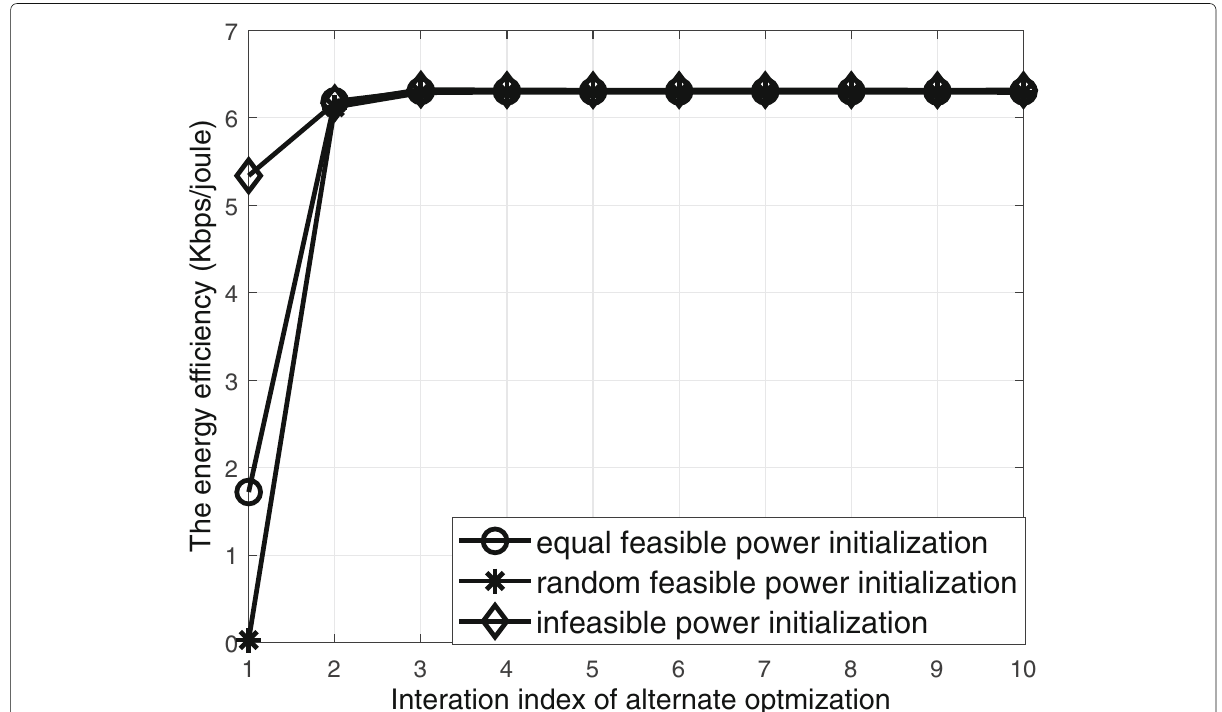
Fig. 3 The convergence of alternate optimization. Convergence behavior of alternate optimization with different initial power allocation